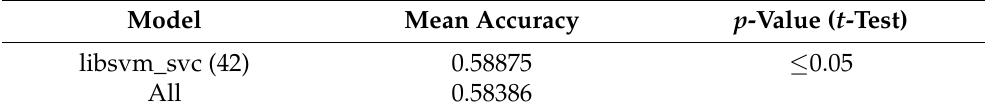
Table A2. Models with significantly better mean